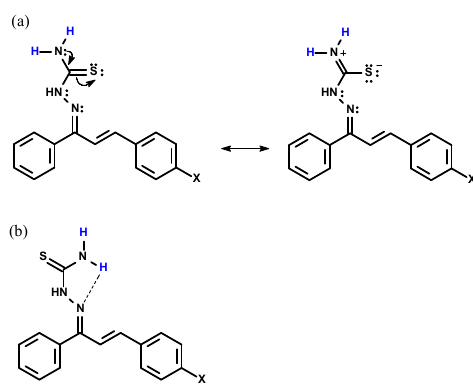
Scheme 2. E ff ects involving the hydrogens H 2 N: ( a ) resonance e ff ect with thiocarbamoyl group; Scheme 2. Effects involving the hydrogens H 2 N: ( a ) resonance effect with thiocarbamoyl group; ( b ) ( b ) intramolecular hydrogen bond between the hydrogen and azomethine nitrogen. intramolecular hydrogen bond between the hydrogen and azomethine nitrogen.